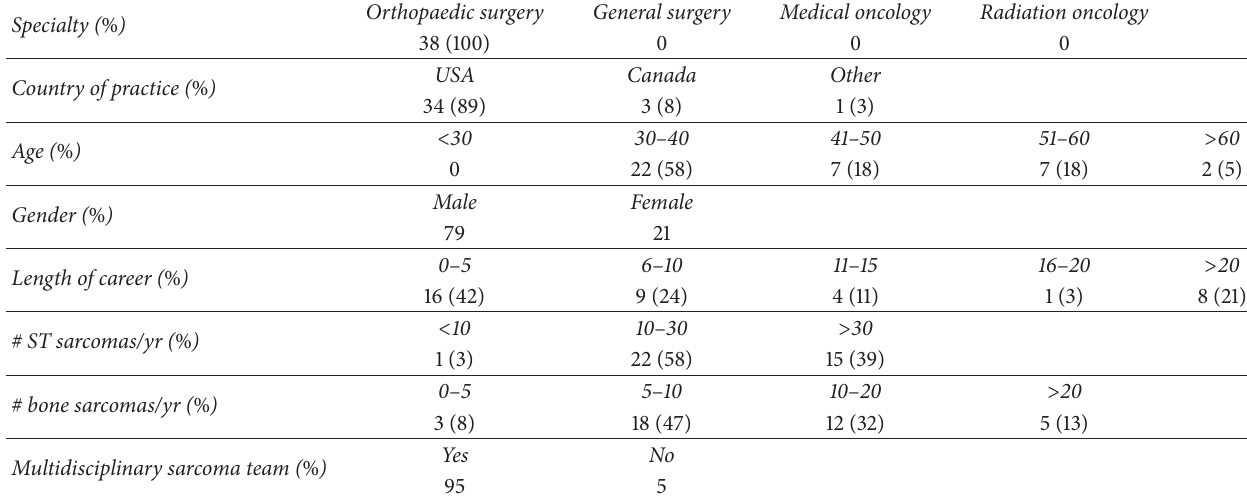
Table 1: The demographic data obtained from the MSTS member